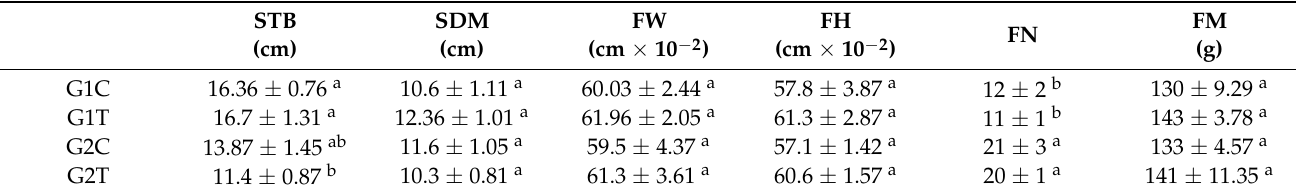
Means with the same letter in the same column are not significantly different from each other according to Tukey’s test ( p < 0.05). Error lines represent ± standard deviation of the mean. Different letters ( a,b ) indicate statistically significant differences according to Tukey’s test ( p <